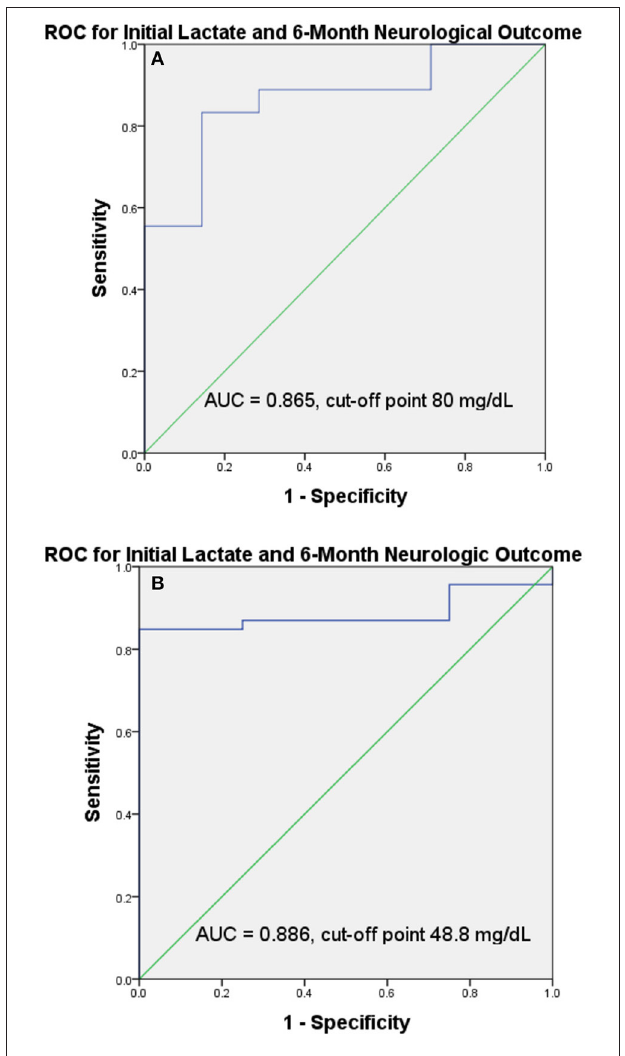
FIGURE 2 | ROC curves and the AUC of the ROC curves and cut-off points for initial serum lactate level. The AUC of the ROC and cut-off points showed that initial serum lactate level had good discriminative power in predicting favorable 6-month neurological outcomes in therapeutic hypothermia group (AUC = 0.865, cut-off point 80 mg/dL) (A) and in normothermia group (AUC = 0.886, cut-off point 48.8 mg/dL) (B) . (AUC, area under the curve; ROC, receiver operating